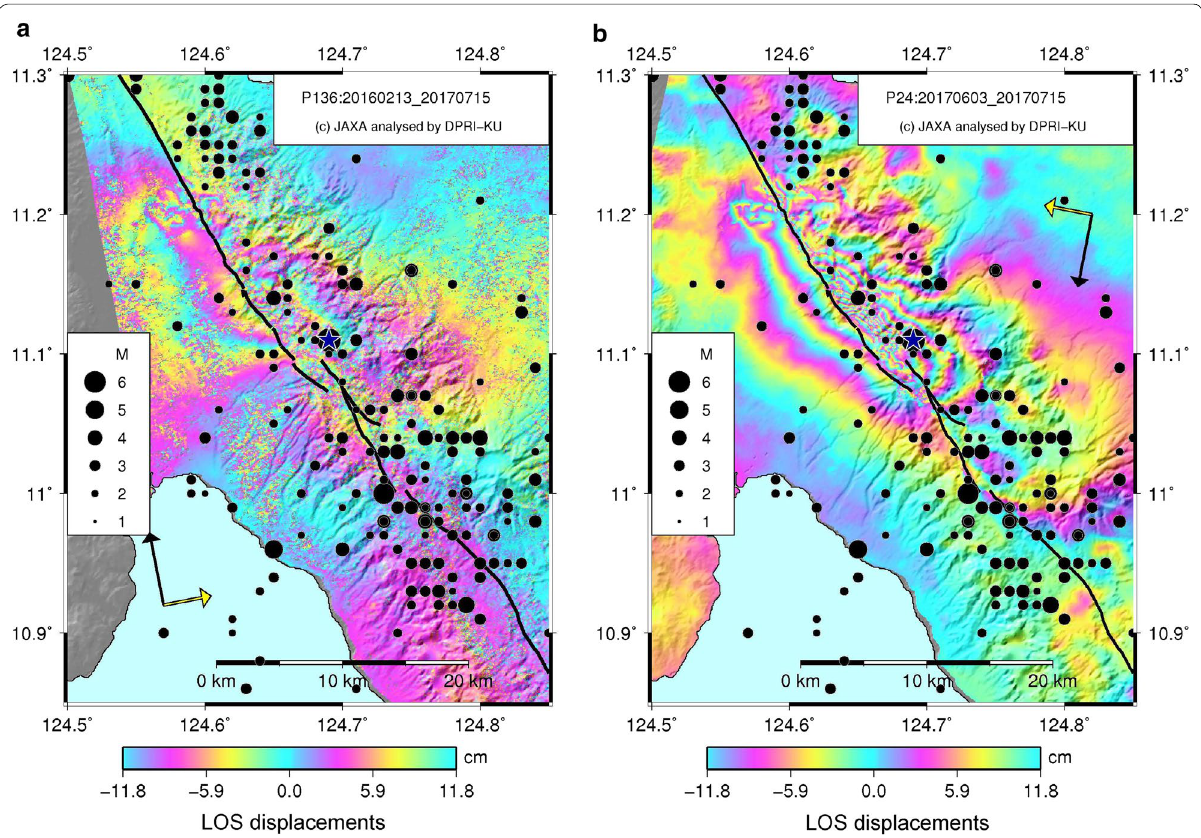
Fig. 11 Ascending ( a ) and descending ( b ) ALOS-2/PALSAR-2 interferograms showing the coseismic displacements of the 2017 Ormoc earthquake, computed and used for estimating the fault slip distribution. Black filled circles are the epicenters of aftershocks (6 July–31 December 2017), and star denotes the epicenter of the mainshock (PHIVOLCS). Black and yellow arrows are the satellite flying direction and the LOS direction,